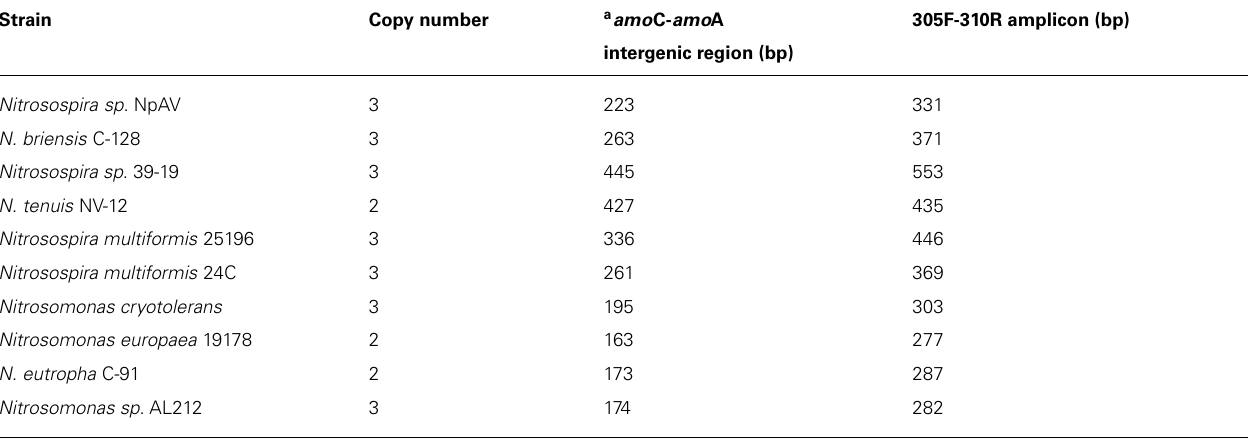
305F-310R amplicon (bp) intergenic region (bp)